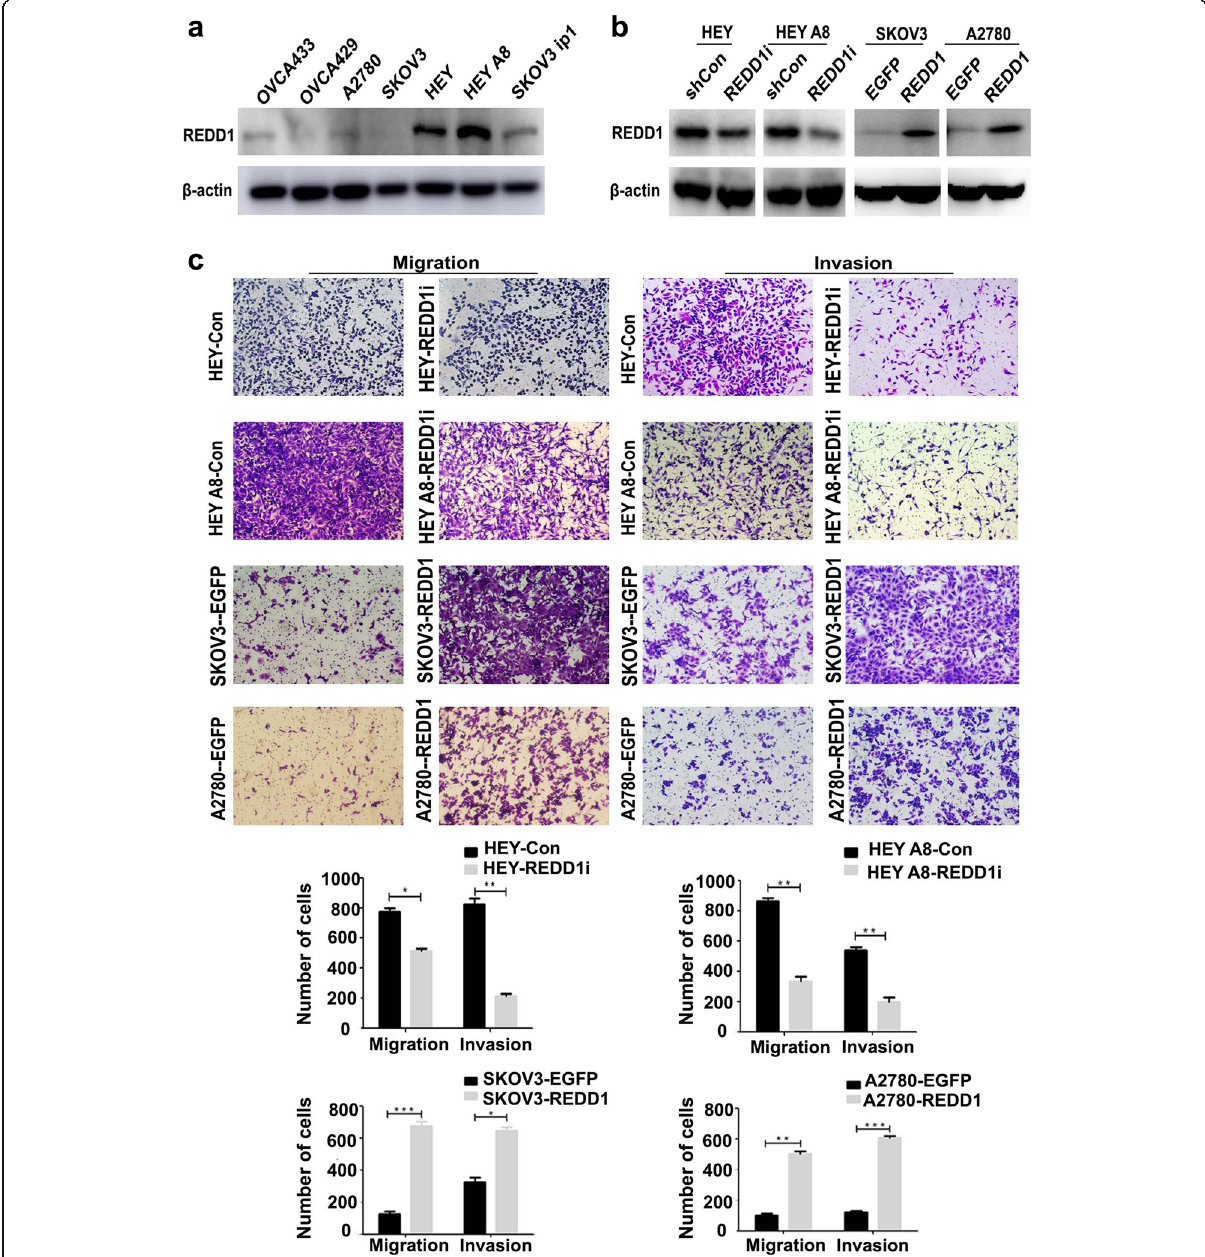
Fig. 3 REDD1 enhance cell migration and invasion in ovarian cancer. a Western blotting detected REDD1 expression level in human ovarian epithelial cancer cell lines. b Construction of ovarian cancer cell lines with REDD1 overexpression or knockdown. c Transwell assays illustrate that REDD1 enhances ovarian cancer cell migration and invasion